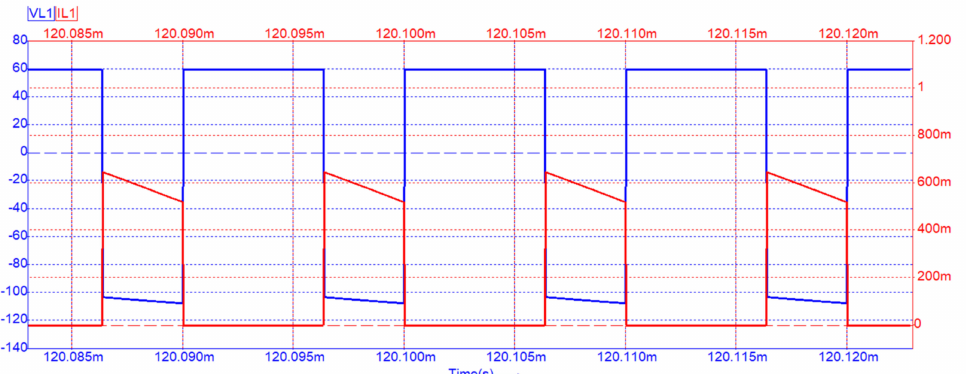
Figure 9. Magnetizing inductor current i LM .